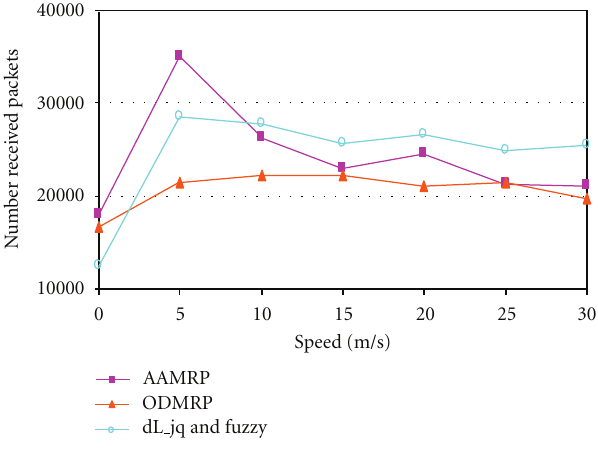
Figure 22: Number of received packets.